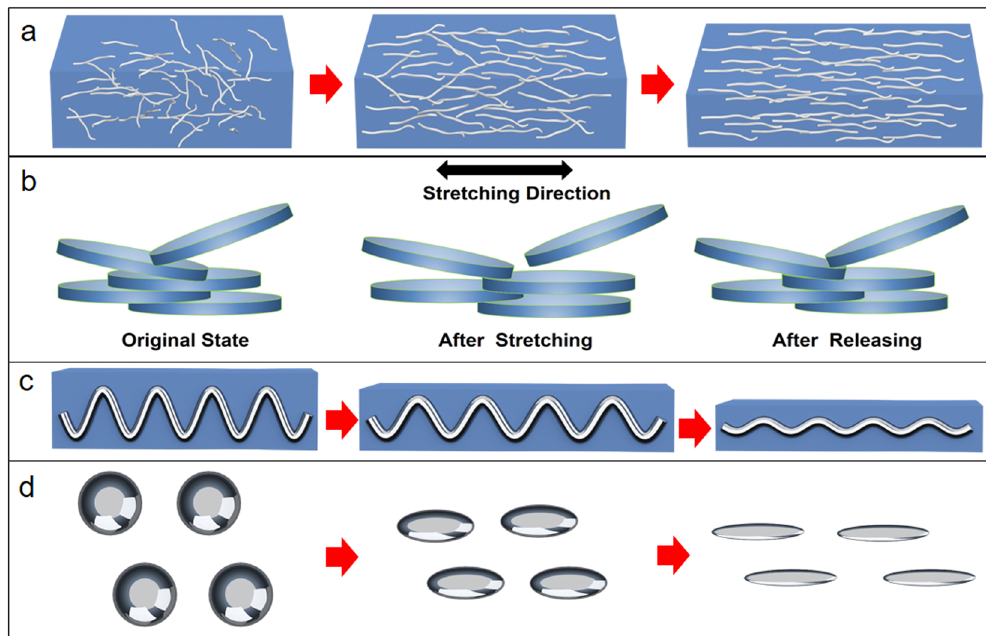
Fig. 1 Schematic diagram of some materials and structures for thermal management of stretchable devices. a High thermally conductive nano fi llers turn aligned under low-level stretching process. b Schematic diagram of the change in thermally conductive pathways during the stretching-releasing process. Reprinted with permission from Sun et al. 24 Copyright 2020 Nature Publishing Group. c Schematic diagram of stable thermally conductive pathways based on the wavy structure during the stretching process. d Schematic diagram of deformable liquid metal that elongates into needle-like microstructures along the mechanically loaded direction to create enhanced thermally conductive